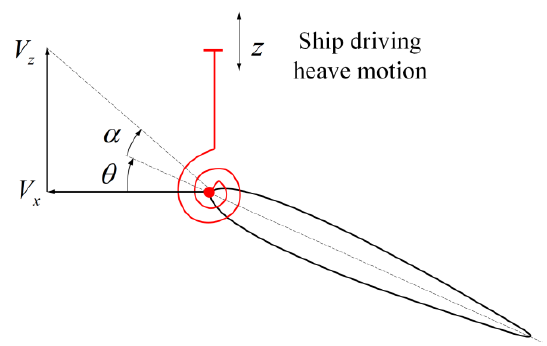
Figure 2. Schematic illustration of semi-passive flapping foil with forced heave motion and attached torsion spring. torsion